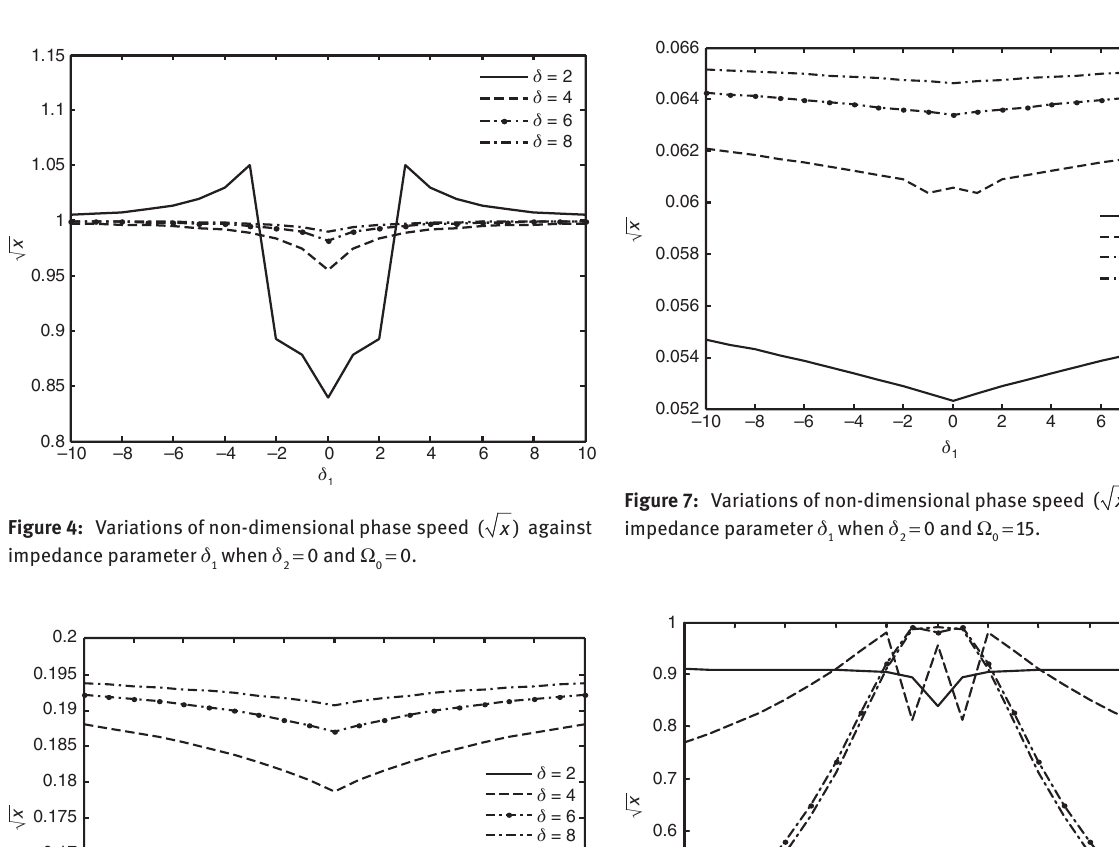
= 0 and Ω = 10. when δ 1 2 0